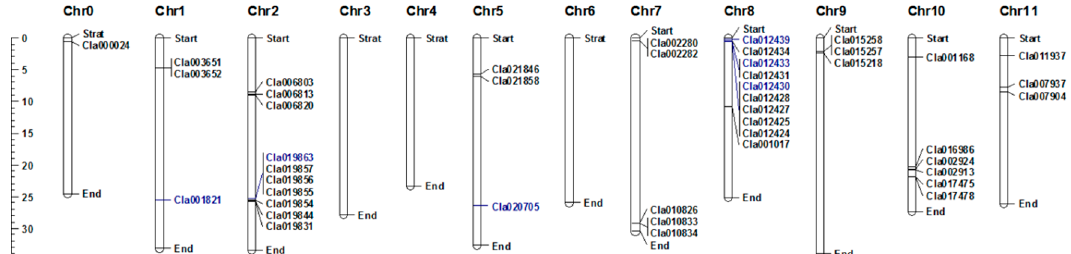
Figure 1. Distribution of the 44 NBS-encoding R genes on the watermelon chromosomes. The genes shown in blue are the candidate NBS-encoding genes for gummy stem blight resistance in watermelon. The positions of genes on the watermelon chromosomes were drawn using MapChart software [22].